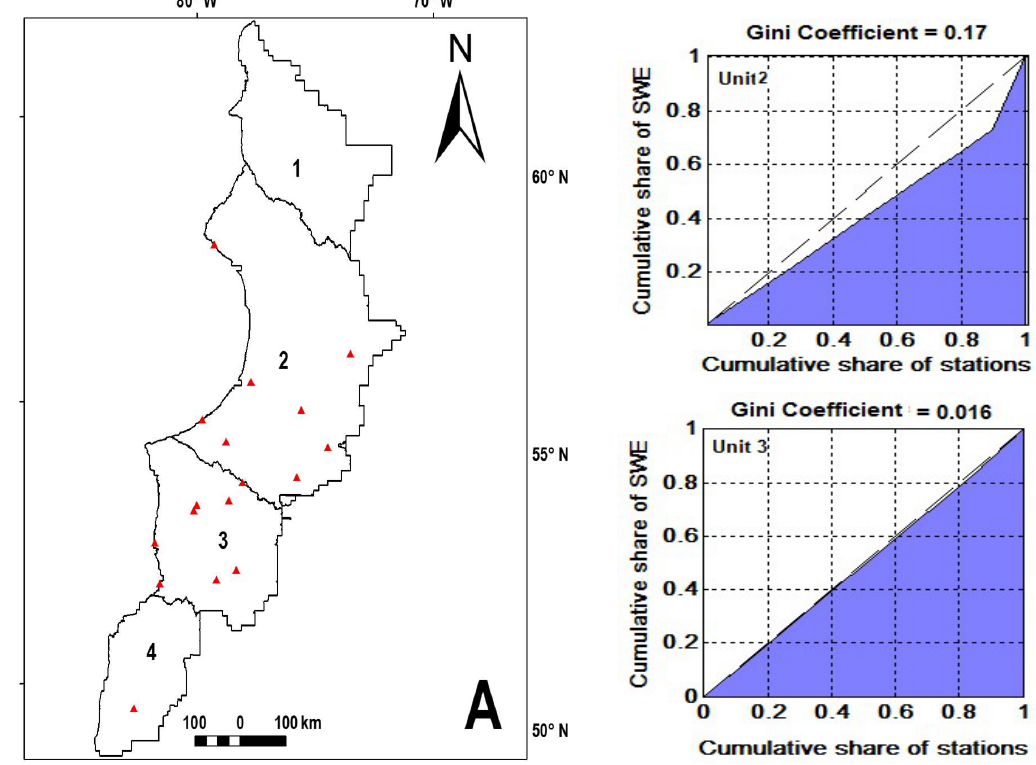
Figure 6. Lorenz curves and values of spatial distribution unevenness of stations in units 2 and 3 at the local scale of zone A (units 1 and 4 lacked sufficient number of stations to undertake the analysis). Spatial unevenness varied in the units of zone B (Figure 7). In unit 1, the snow cover was monitored by a network of evenly distributed snow stations (Gini coefficient = 0) around the main lakes of Churchill Falls’ hydroelectric station. The stations of unit 10 in the southern part of zone B were distributed similar to those of unit 1, with a slight station grouping in the southern center. West of zone B, in unit 2, 62% of the mean annual maximum SWE data were derived from 82% of the stations, which were located along the central Great Lakes. In the fifth unit of zone B, in the South, on the tributaries of the Manicouagan Reserve and the foothills of the Veyrier and Groulx Mountains, 70% of the snow stations contributed 35% of the snow data. As a result, the entire northern part of unit 5 was devoid of stations, resulting in a Gini coefficient of 0.34. Such an uneven distribution could be observed in unit 6, where the stations that were distributed east of the mountain foothills (Tesmicamie 554 m and Helon 467 m) and at the edge of the Northern lakes (38% of the stations) provided only 15% of the mean annual maximum SWE data. The central part of unit 6 was also not well-covered, which was confirmed by a Gini coefficient of 0.22. The spatial distribution of the stations in unit 7 was even less scattered, where the stations were aligned on the North–South axis, resulting in a Gini coefficient of 0.3. This uneven spatial distribution was confirmed, with 49% of the stations providing 19% of the data of the mean annual maximum SWE. A similar Gini coefficient value (0.27) was observed in unit 9, where 35% of the stations provided less than 10% of the mean annual maximum SWE data.